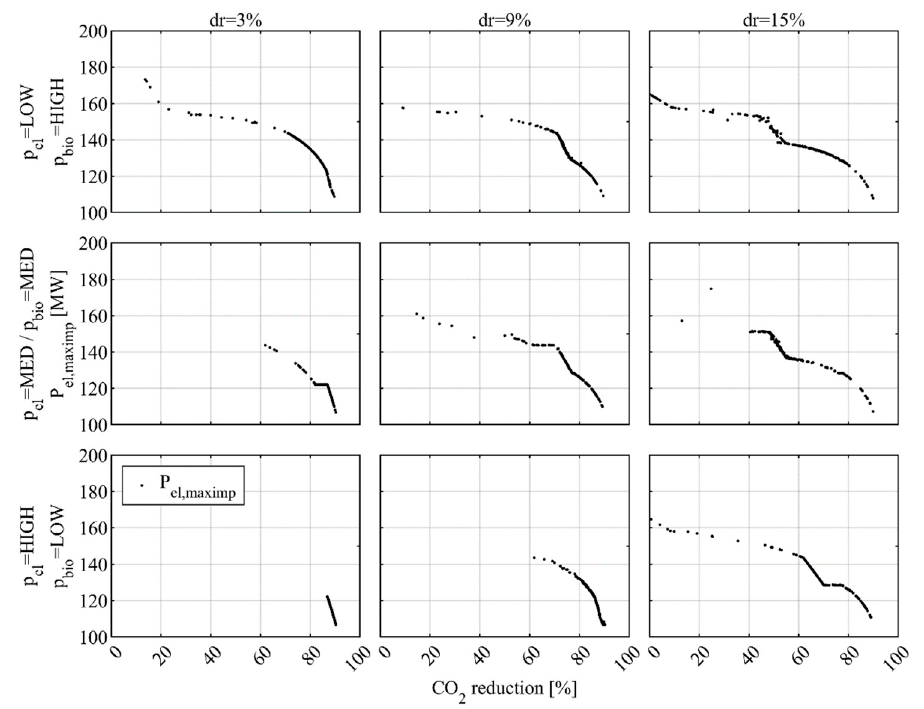
Figure 6. Electricity and heating sectors, P el,maximp with all decision variables, sensitivity analysis for p el and dr .